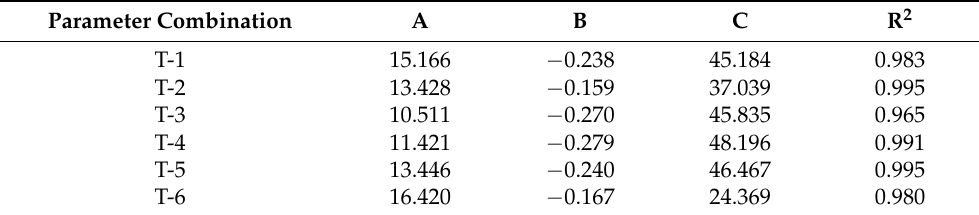
Table 10. Attenuation parameter of stress concentration coefficient.